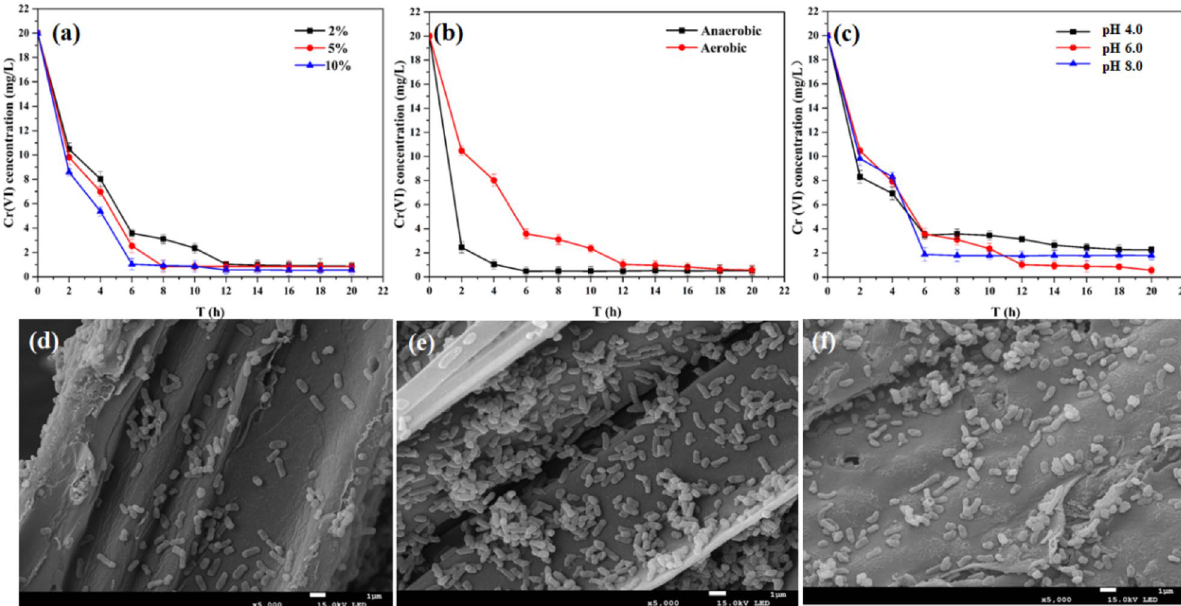
Figure 4. Effect of ( a ) inoculation amount, ( b ) oxygen condition, and ( c ) solution pH on Cr(VI) removal rate. Experimental conditions: Cr(VI) concentration 20 mg L −1 , solution volume 100 mL and reaction time 24 h. ( d – f ) the stability of K. variicola H12-CMC-FeS@biochar under pH 4.0, pH 6.0, pH 8.0